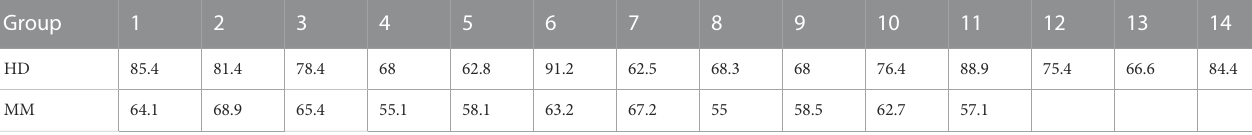
TABLE 1 The proportion of moDCs in the harvested cells (%) in the HD group ( n = 14) and the MM group ( n = 11). Group